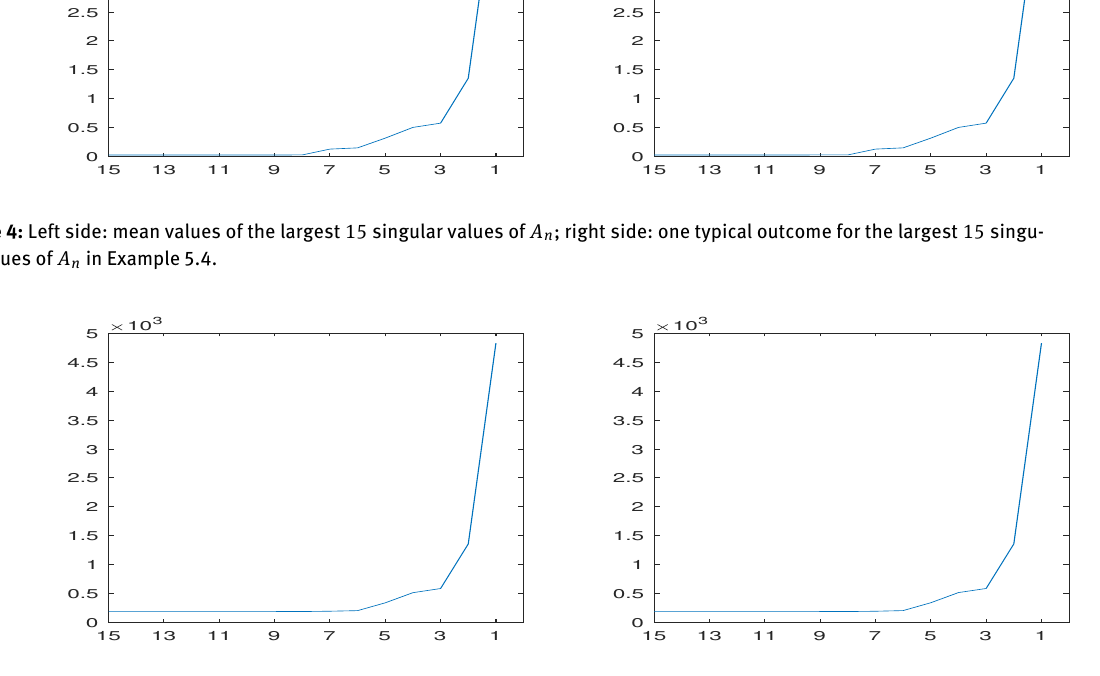
Figure 5: Left side: mean values of the largest 15 singular values of A n ; right side: one typical outcome for the largest 15 singu- lar values of A n in Example